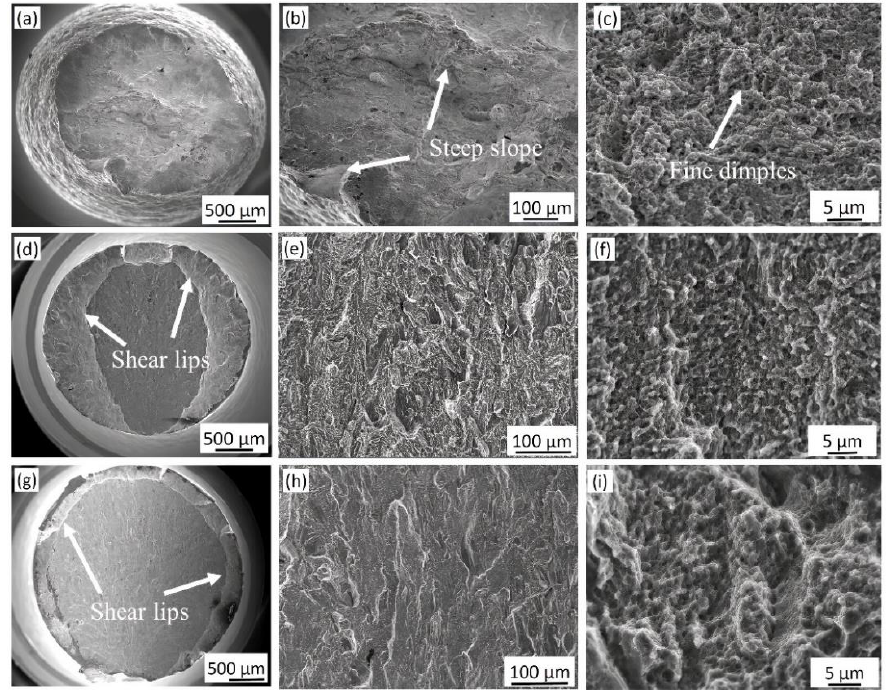
Figure 4 . SEM images of the fracture surfaces and dimples of 316 L: ( a – c ) room temperature specimen 1, ( d – f ) − 196 ◦ C specimen 3, and ( g – i ) − 196 ◦ C specimen